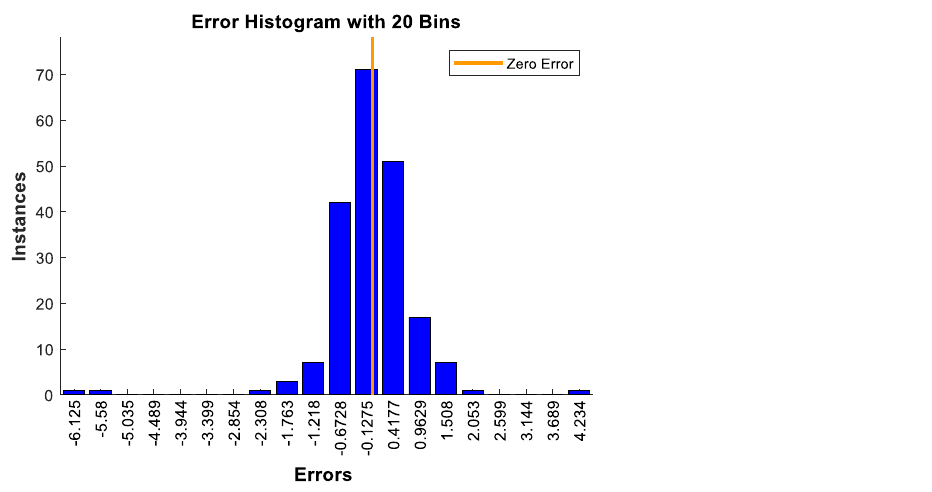
Figure 9. The ANN error histograms for µ nf